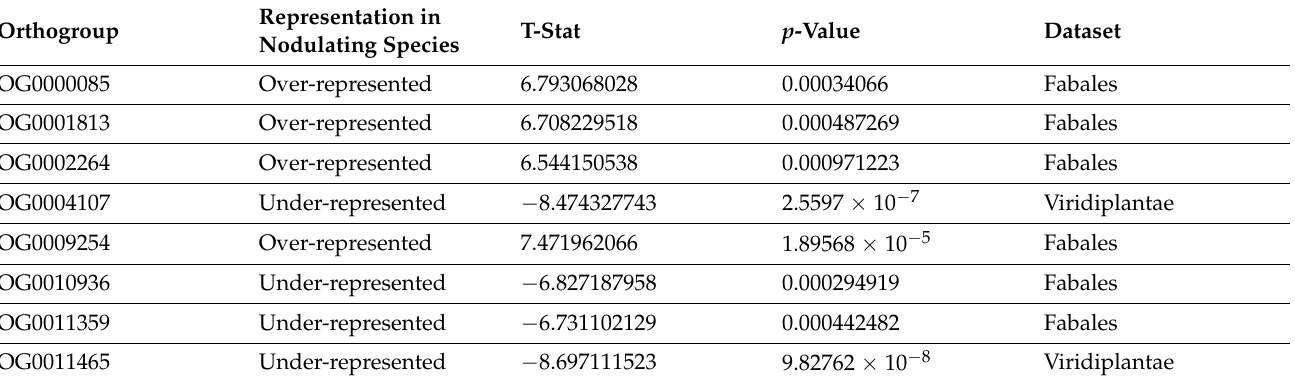
Table 4. Gene families differentially represented in nodulating and non-nodulating species. Student’s t-test for normalized gene counts. Dataset column indicates the mode of comparison: Fabales denotes nodulating Fabales vs. all other taxa (including non-nodulating legumes), Viridiplantae denotes all known nodulators among green plants vs. all